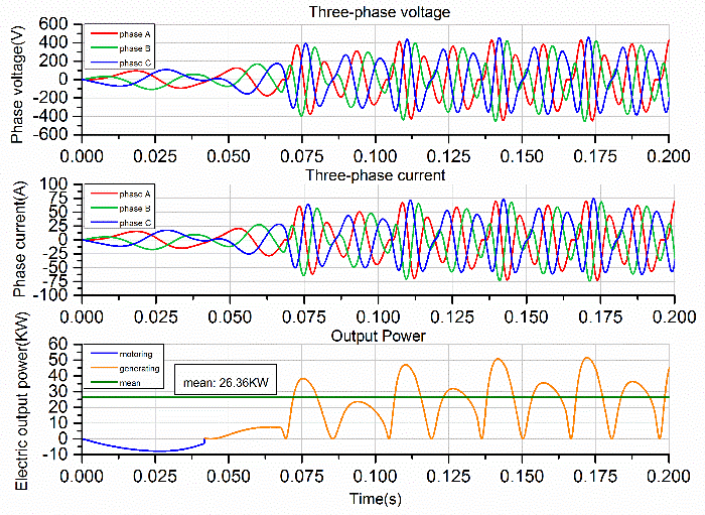
Figure 15. Three-phase voltage, current and electric power output.